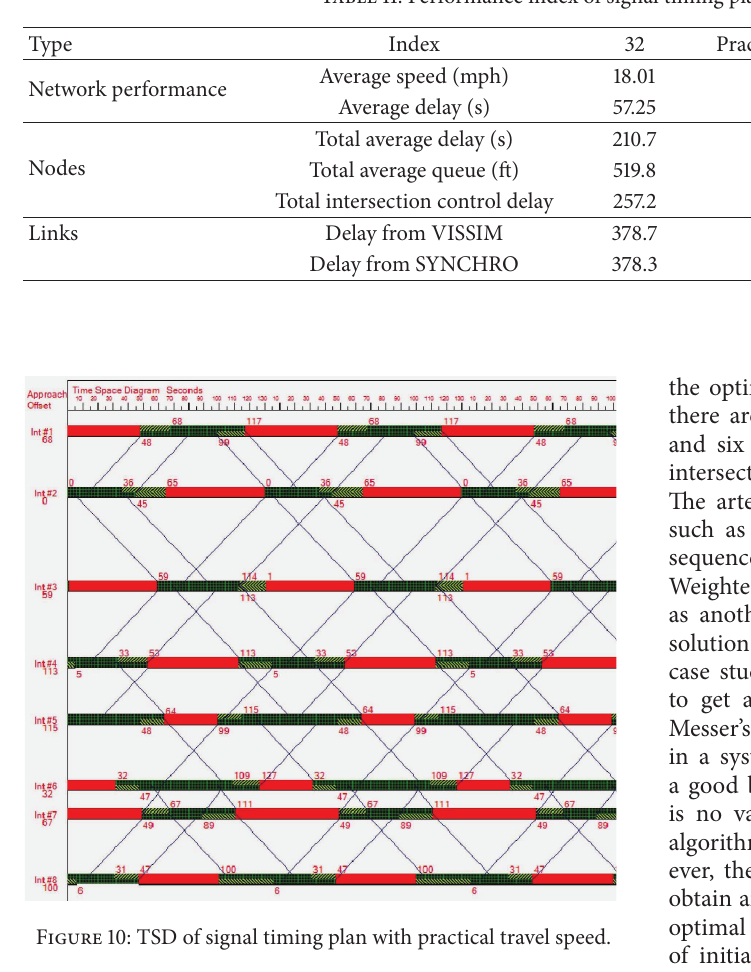
Table 11: Performance index of signal timing plans with different speeds.